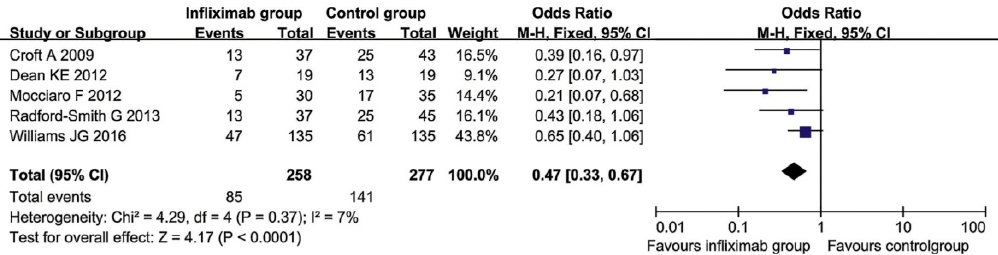
Figure 10. Forest plot of colectomy rates in the infliximab group for 12 months and in the control group [104].